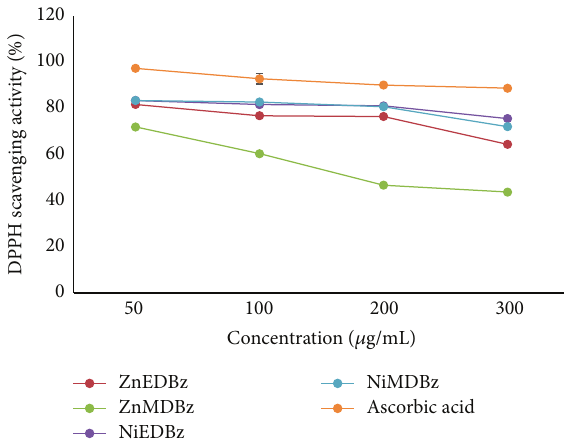
Figure 4: Graph representing DPPH radical scavenging ability of the compounds.